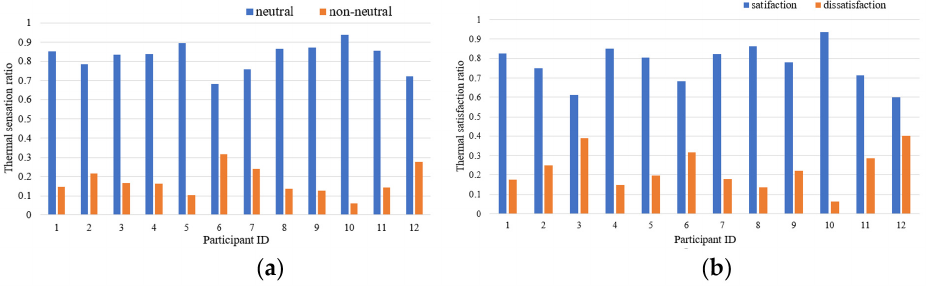
Figure 10. Comparison between votes for neutral and non-neutral sensation/satisfaction. ( a ) Sensation; ( b ) Satisfaction. tion; ( b )